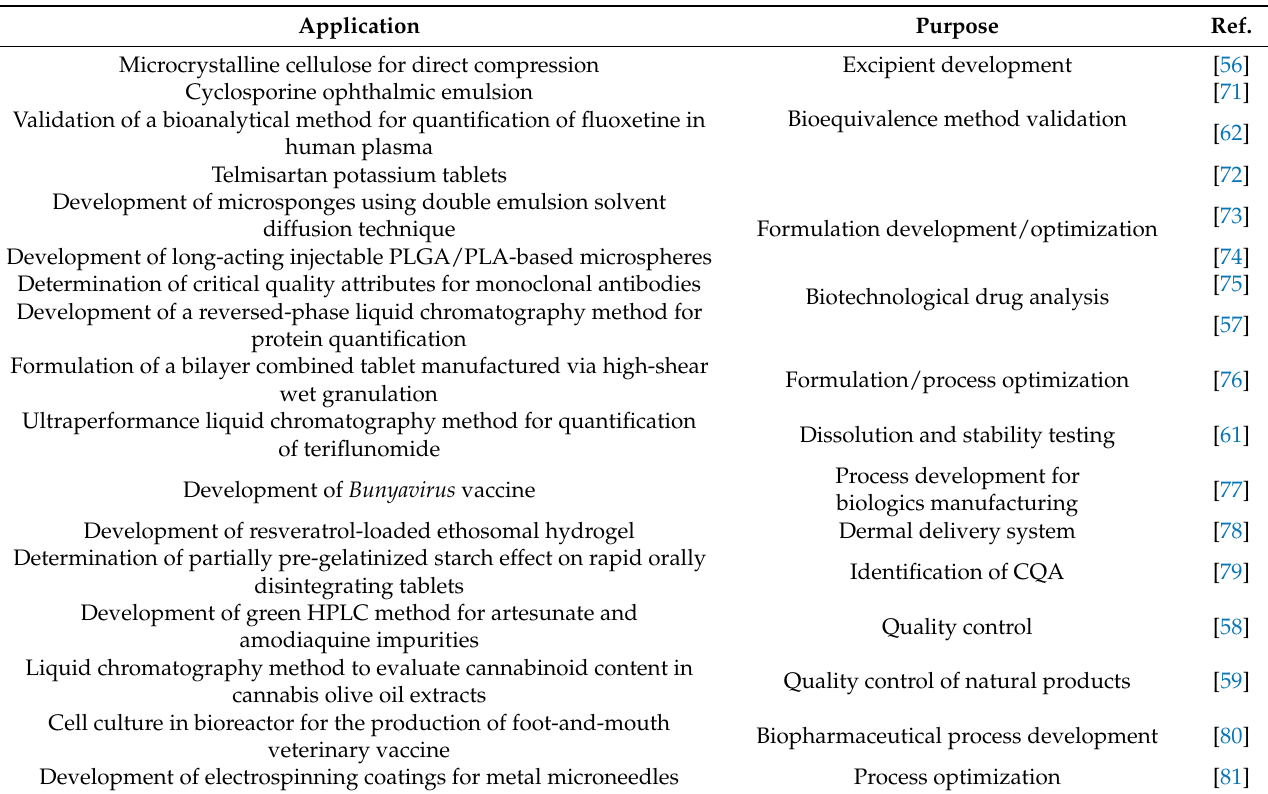
Table 1. Quality by Design applications in Pharmacy and Pharmaceutical Sciences developed by the